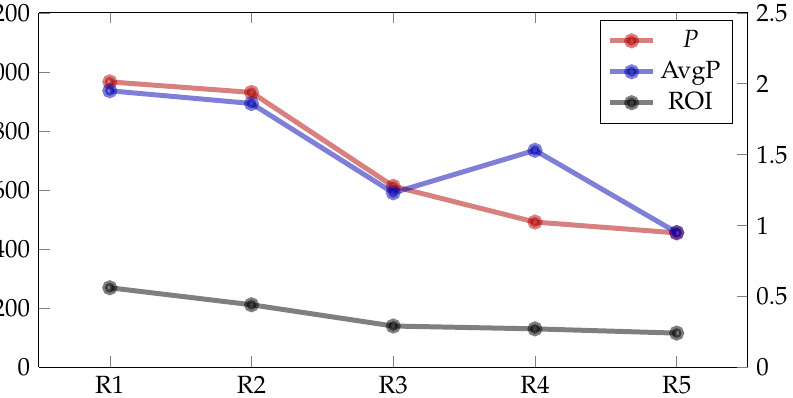
Figure 1. Values of P (left axis) and AvgP and ROI (right axis) indicators obtained using 5 best-rated rules determined to maximize P